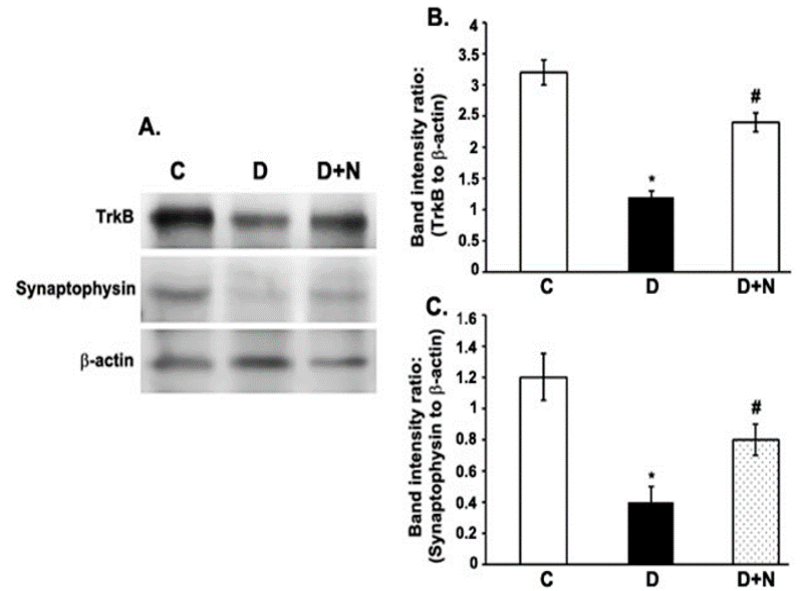
Figure 4. Western blot analysis of the expression of TrkB and synaptophysin in retinas from control, diabetic, and naringenin-treated diabetic rats. The intensities of the bands were quantified by densitometry. ( A ) Representative immunoblots of TrkB and synaptophysin and β -actin bands; Panel ( B , C ) Data presented as ratios of those protein bands to β -actin. Values are means ± SEM; n = 6/group. * p < 0.05, significantly different from their controls; # p < 0.05, significantly different from diabetic. TrkB; Tropomyosin receptor kinase. C represents control, D as diabetic, and D + N as diabetic rats treated with naringenin.